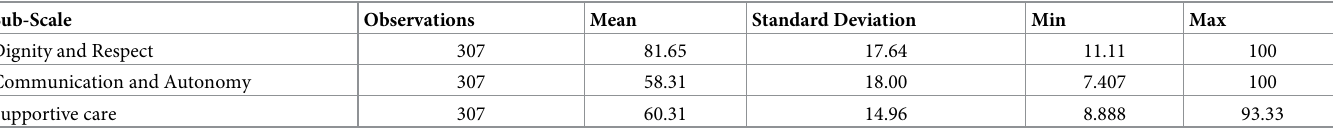
Table 3. Sub-scale normalized